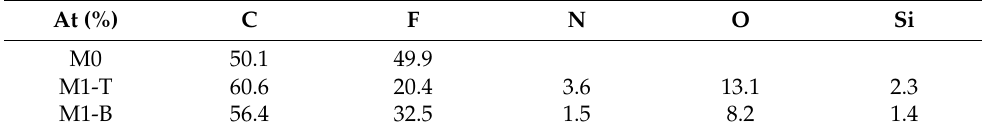
Figure 4. Chemical analysis of M1 and M0: comparisons of ( a ) chemical groups and ( b ) constituent elements for the top (T) and bottom (B) surfaces of M1 and M0. Table 2. Chemical element content on membrane surfaces of M0 and